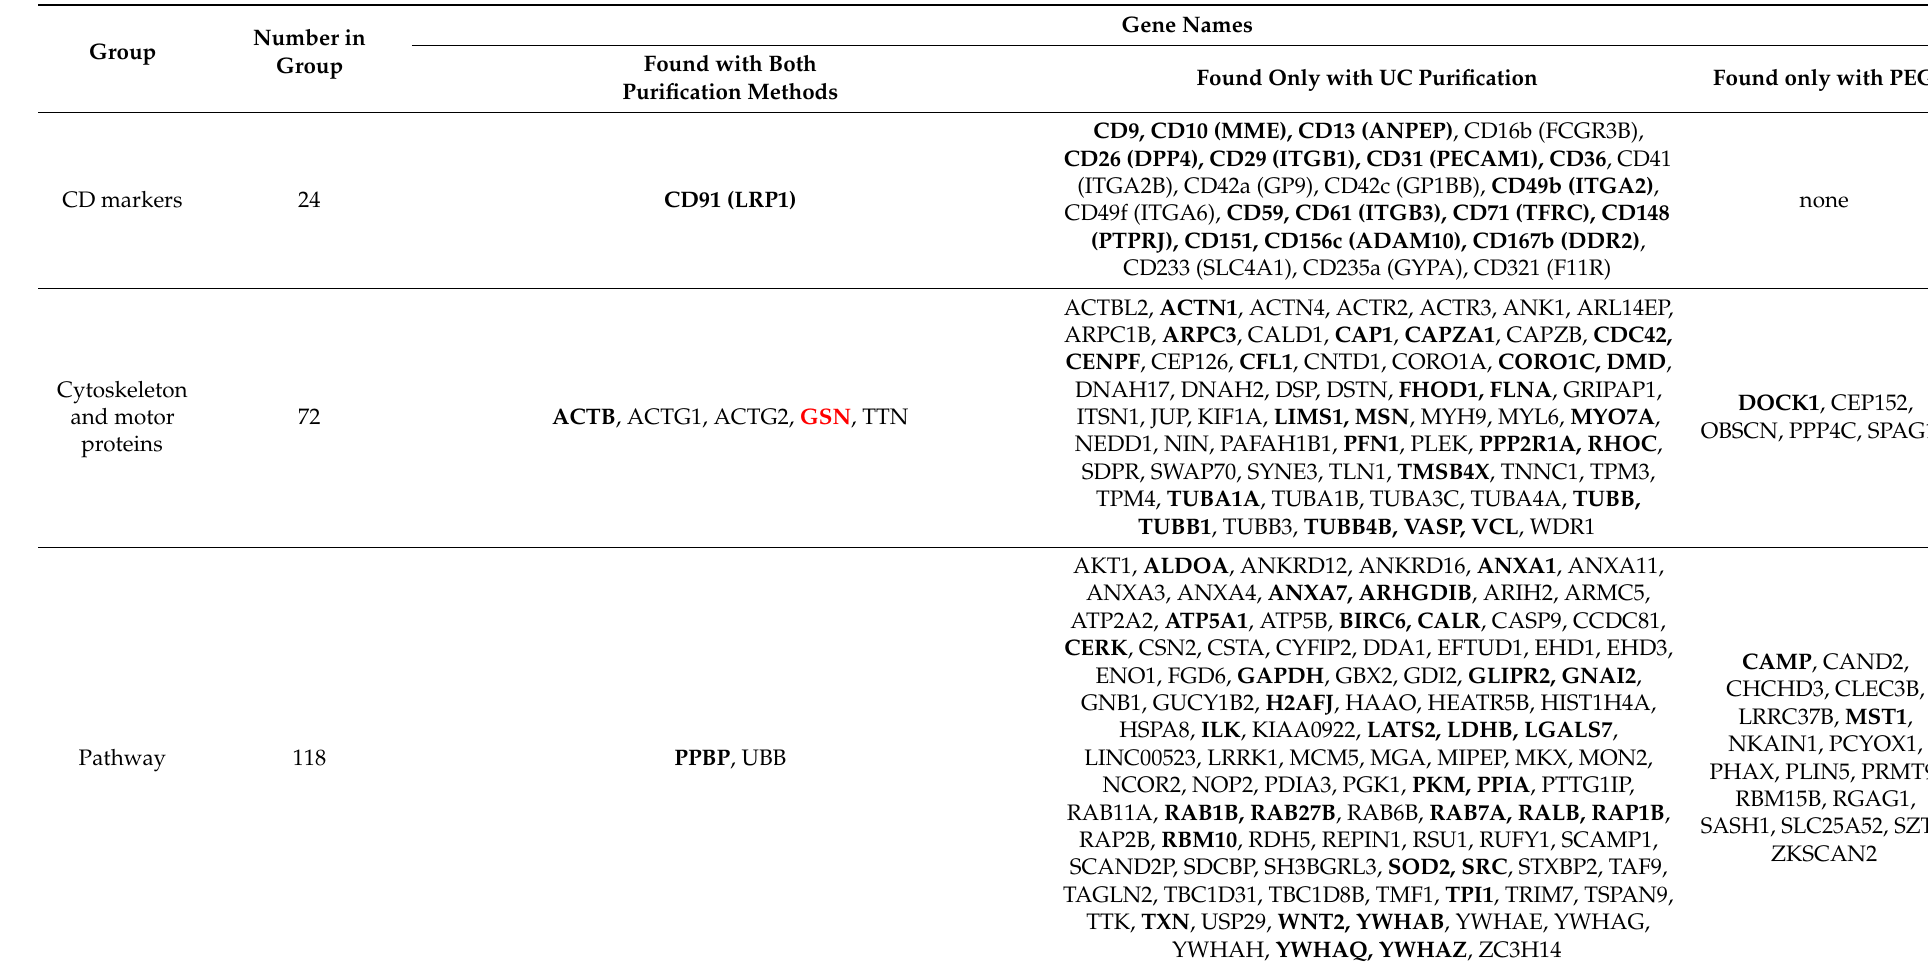
Table 2. Proteins found with proteomics with both purification methods. All proteins that have been linked to melanoma in previously published literature are in bold. Three proteins that were used in western blot are